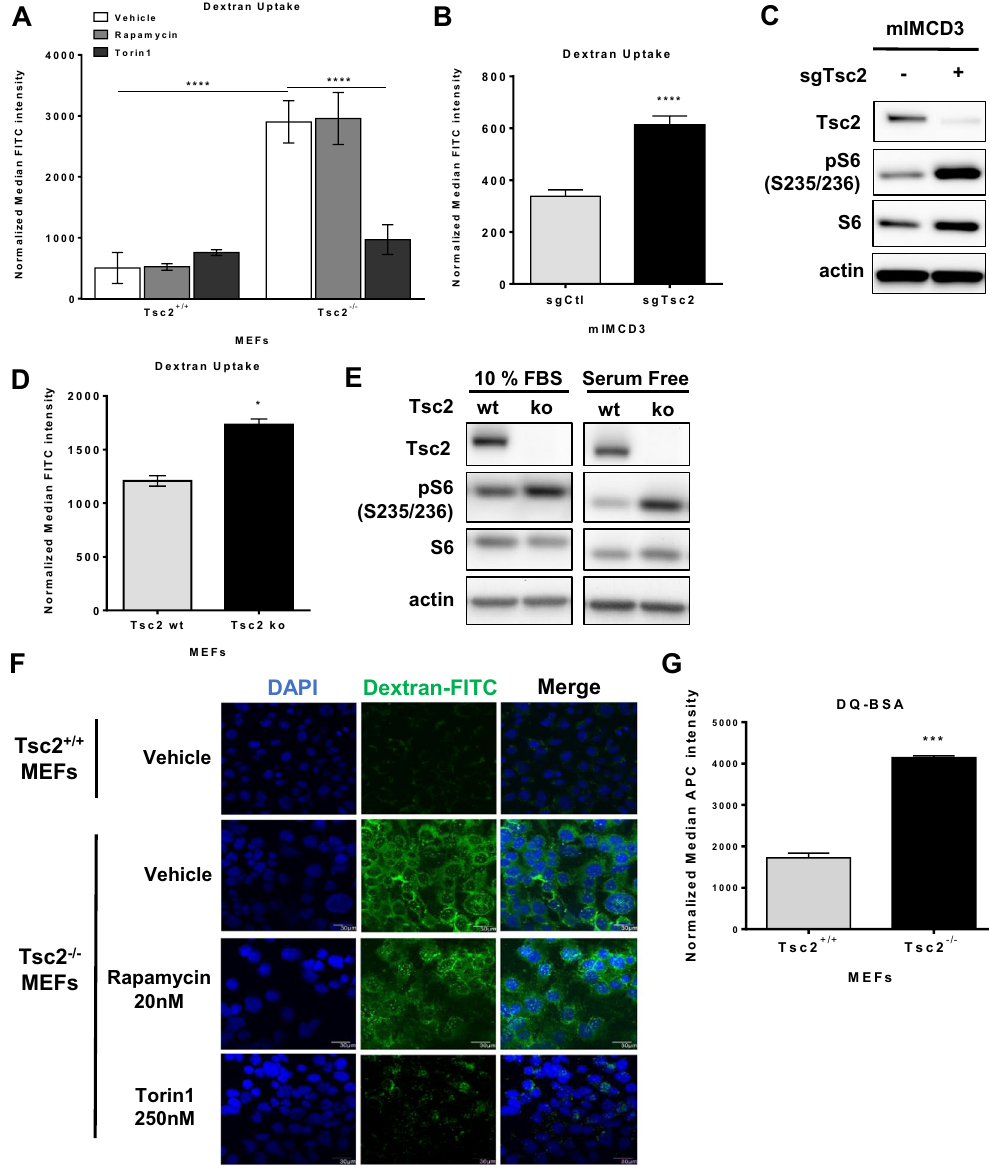
Figure 1. Macropinocytosis is increased in Tsc2-deficient cells. ( A ) Uptake of macropinocytotic cargo dextran (FITC-Dextran, 70 kDa; 0.5 mg/ml) was significantly increased in Tsc2 − / − MEFs compared to Tsc2 + / + MEFs. Rapamycin (20 nM) had no impact on macropinocytosis in Tsc2 − / − MEFs, while Torin1 (250 nM) reduced dextran uptake to levels comparable to Tsc2 + / + MEFs. ( B ) Increased dextran uptake in mouse inner medullary collecting duct epithelial cells (mIMCD3) with Tsc2 knockout (sgTsc2) compared to sgCtl cells. ( C ) Immunoblot of serum starved mIMCD3 cells showing knockout of Tsc2 and increased phosphorylation of S6 ribosomal protein. The blot was cropped to highlight the relevant bands. The full-length blot is presented in Supplementary Figure 2B. ( D ) Increased dextran uptake in Tsc2-deficient embryonic fibroblasts (MEFs) derived from Tsc2 fl/fl Rosa26-CreERT2 mice (Tsc2ko) compared to Tsc2-expressing MEFs (Tsc2wt). ( E ) Immunoblot of MEFs treated with ethanol or 4-hydroxytamoxifen to knockout Tsc2. Cells were either grown in 10% FBS DMEM or serum starved for 16 hours. ( F ) Representative images of Tsc2 + / + and Tsc2 − / − MEFs treated for 24 hours with vehicle, rapamycin (20 nM) or Torin1 (250 nM). The macropinocytic cargo dextran was internalized at higher levels in Tsc2 − / − MEFs, compared to Tsc2 + / + MEFs. Rapamycin did not impact macropinocytosis in Tsc2 − / − MEFs. FITC-Dextran uptake decreased with Torin1. ( G ) Increased DQ Red BSA processing in Tsc2 − / − MEFs, compared to Tsc2 + / + MEFs. Data represented as mean + / − standard deviation of three biological replicates. Statistical significance was assessed using two-way and one-way ANOVAs with Bonferroni correction with * p < 0.05, *** p < 0.001, **** p <